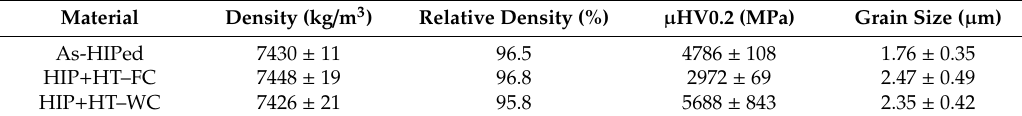
Table 5. The density, hardness, and grain size data of the tested specimens.